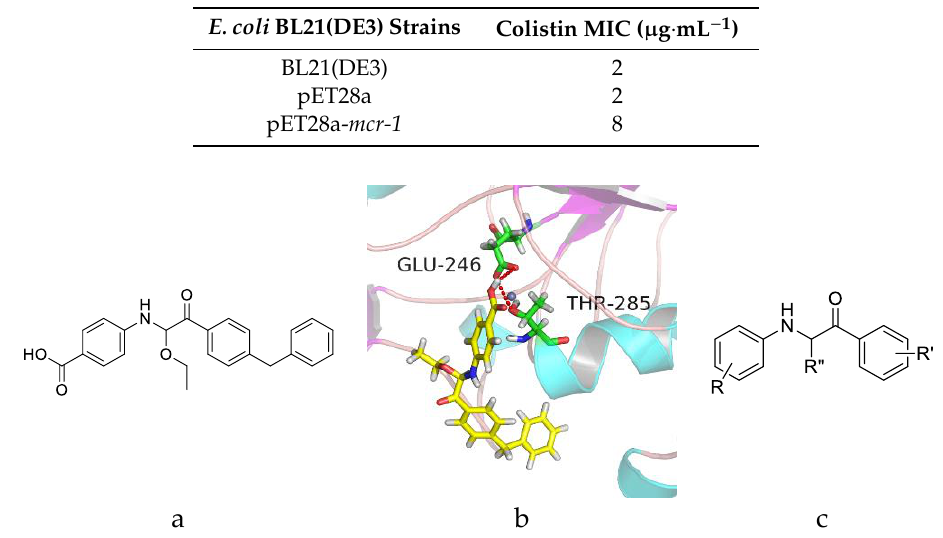
Table 1. The colistin MIC of Escherichia coli BL21(DE3) strains that carry the mcr-1 gene.